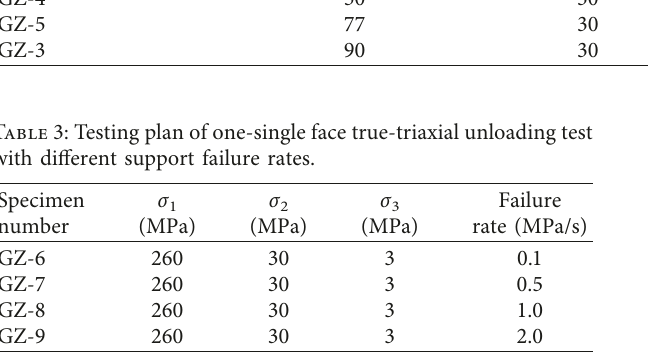
Table 2: Testing plan of one-single face true-triaxial unloading test with different support failure timings. Specimen number